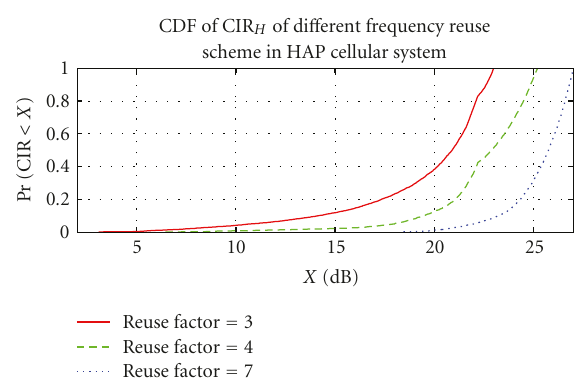
Figure 15: DL CIR H performance of HAP system with di ff erent values of the reuse factor N (3, 4, and